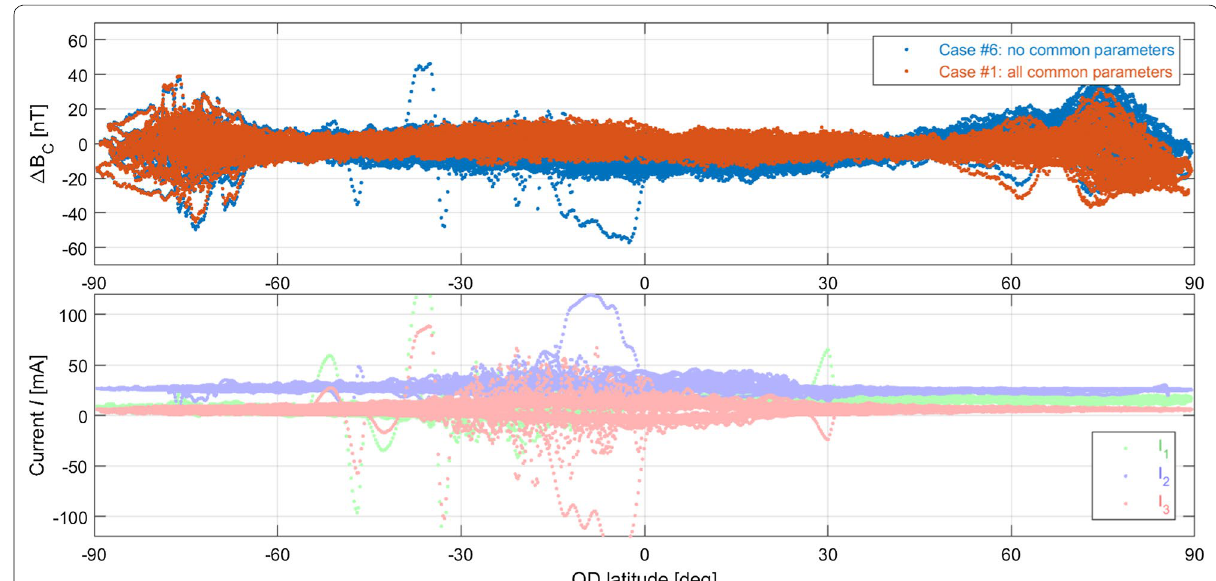
B C B C Fig. 4 Top: residuals (cid:31) B C ,mod in dependence on QD‑latitude for the 2 days 3 to 4 April 2011, for FGM1. Blue dots present results when = − discarding “common calibration parameters” (i.e. not accounting for spacecraft disturbance fields and magnetometer non‑linearities—case #6 of Table 1) while red dots present results for the fully calibrated data (case #1). Bottom: magnetorquer currents in dependence on QD‑latitude for the same data